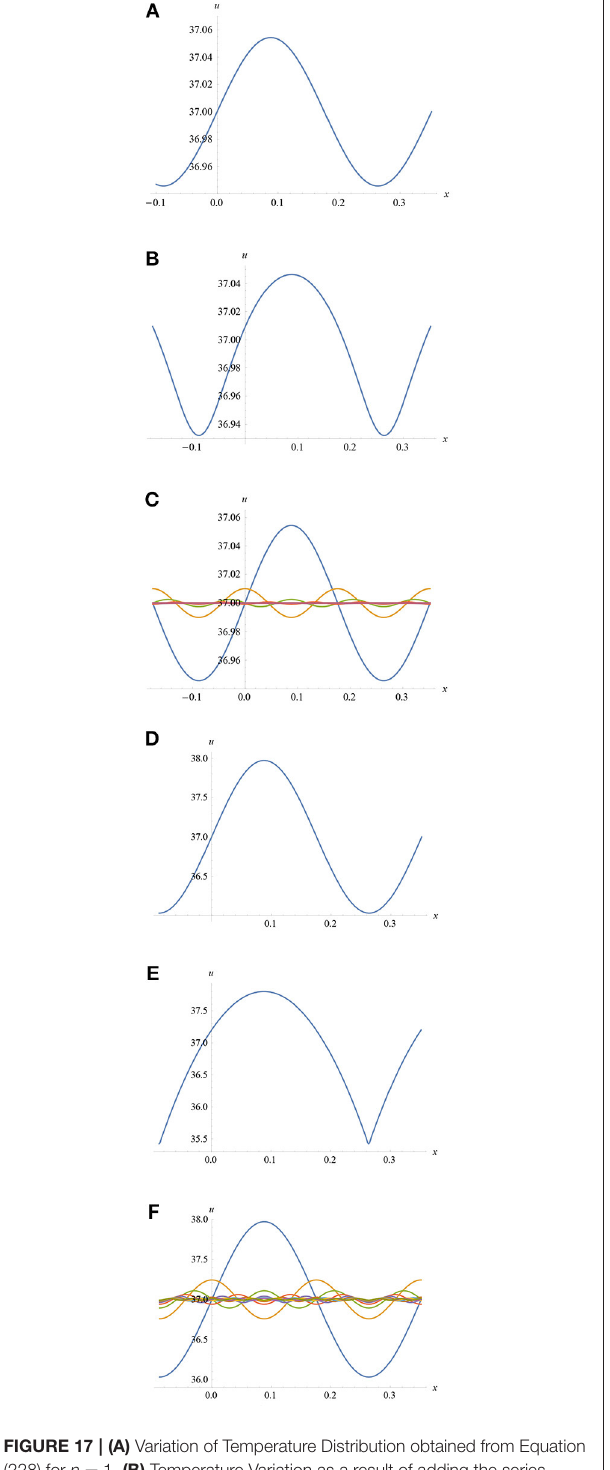
FIGURE 17 | (A) Variation of Temperature Distribution obtained from Equation (228) for n 1. (B) Temperature Variation as a result of adding the series = defined by Equation (228) for n 1 to 50. (C) Individual Temperature Profiles = for n 1, 2, 3,..., generated by Equation (228). (D) Variation of Temperature = Distribution obtained from Equation (229) for n 1. (E) Temperature Variation = as a result of adding the series defined by Equation (229) for n 1 to 50. (F) = Individual Temperature Profiles for n 1, 2, 3,..., generated by Equation =